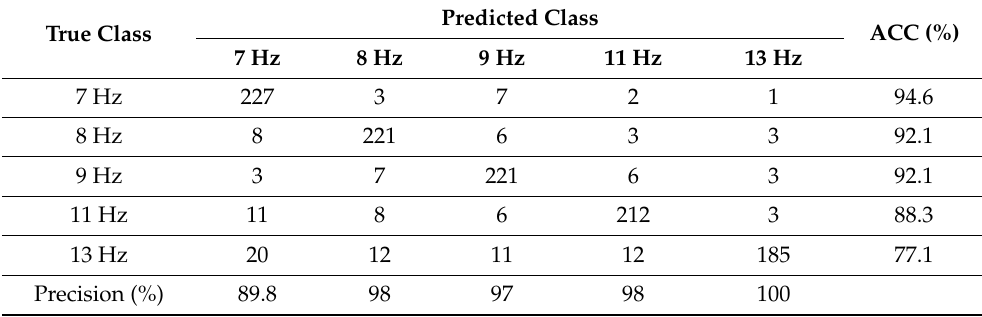
Table 2. The confusion matrix for the SSVEP recognition results using CCA classifier for the room information test in the first experiment (Scenario